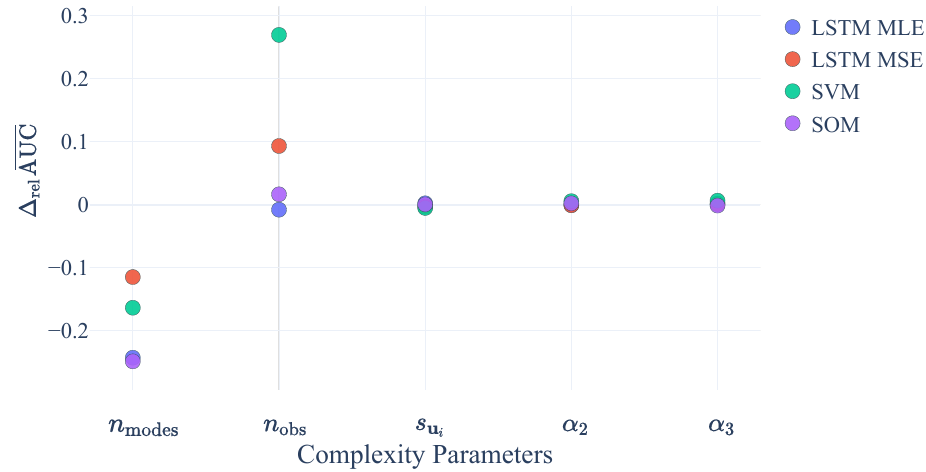
Figure 4. Relative difference of average area-under-the-curve (AUC) values ∆ rel AUC (see text for exact definition) as a function of five parameters that are relevant for data